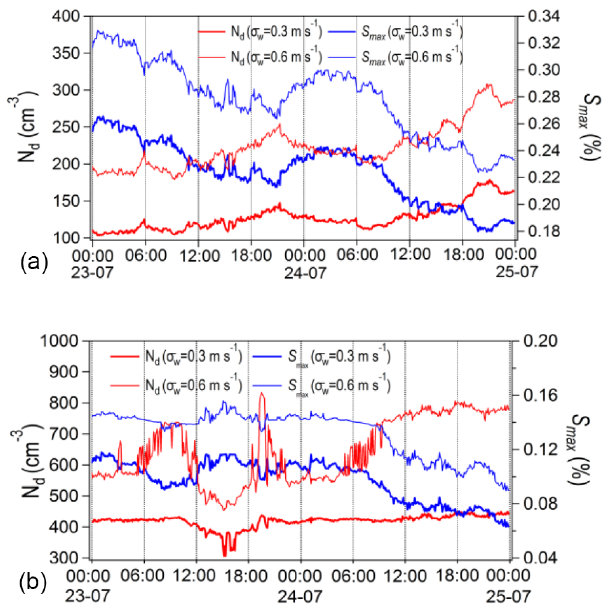
Figure 9. Time series of the CN and estimated CCN concentration particles for various supersaturations at Santorini (top panel) and Finokalia (bottom panel) on 23 and 24 July (EF). Time is in LST.